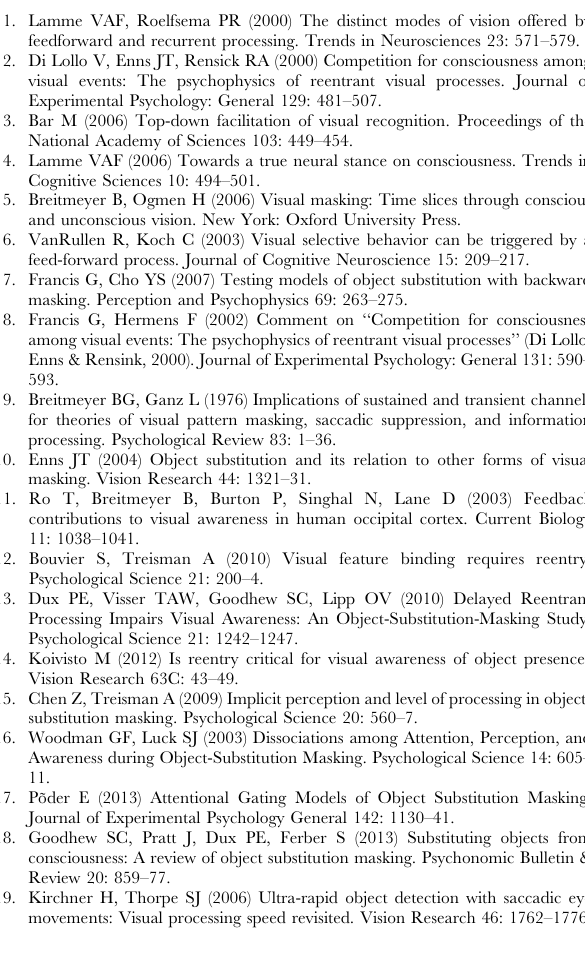
Figure S2 Cumulative distribution of correct and incor- rect SRT for each observer in each condition.